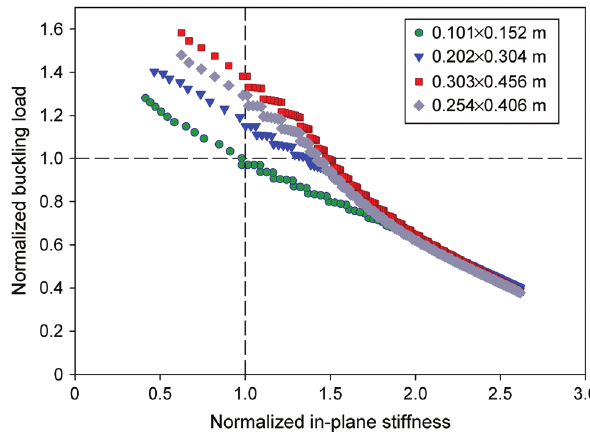
Figure 3 Pareto sets obtained by maximizing the buckling load and in-plane stiffness for four plate sizes.